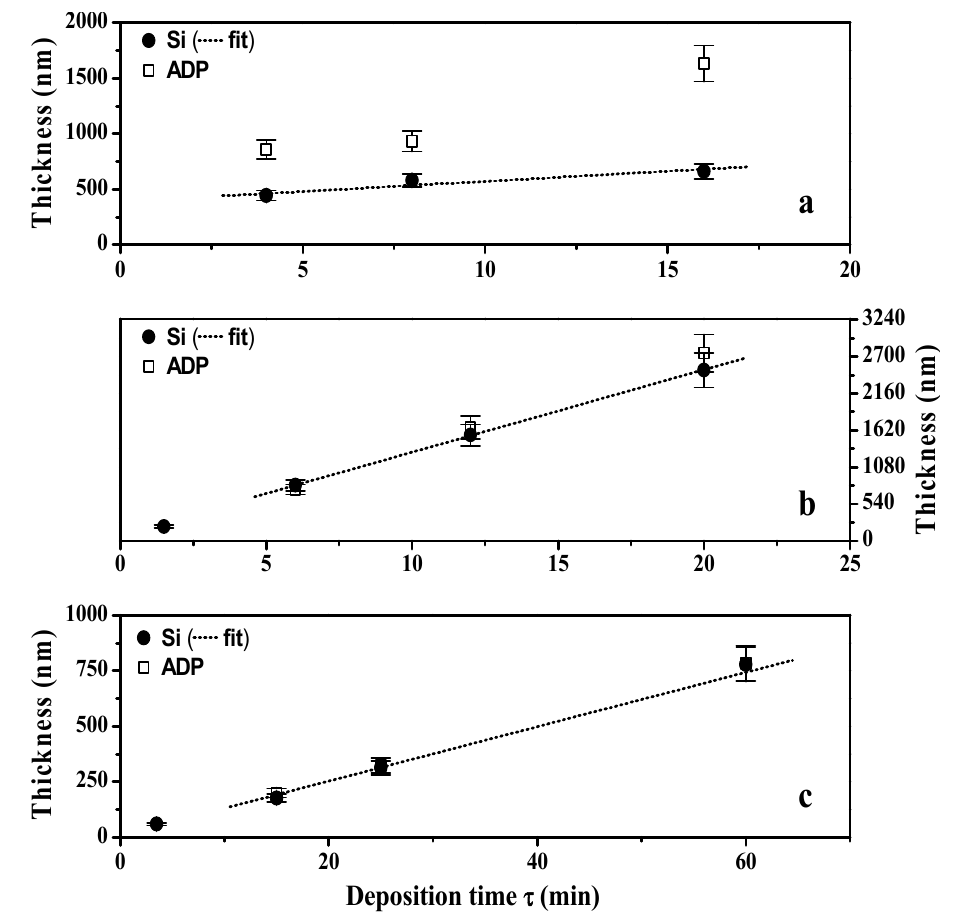
Figure 3. Thin films thickness as a function of deposition time ( τ ) both on silicon wafer and ADP-Morgane ® membrane. Plasma polymerization was performed in the following conditions: ( a ) P = 150 W, DC = 100%; ( b ) P = 40 W, DC = 100%; ( c ) P = 40 W, w w w DC = 10%. The straight dotted lines labeled as fits correspond to linear regressions of the deposit growth on silicon wafer for deposition times above 2 min (once the permanent regime reached).